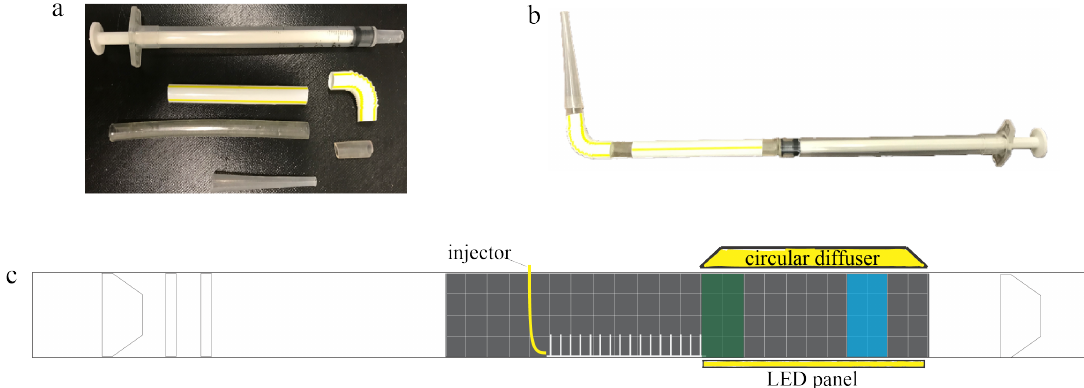
Figure 4. Larvae injector with a modified tip design: ( a ) the injector was constructed using a 1-mL insulin injector, 65-mm and 10-mm sections of aquarium tubing with 5 mm diameter, a straight 45-mm plastic straw piece, a 19-mm bendy section of the straw, and the tip of a 3-mL pipette that has an opening that is 2 mm in diameter and 35 mm in length; ( b ) the complete injector as assembled; and ( c ) flow tank setup for the dispersal experiments. The injector was positioned immediately upstream of the macrophyte model. Green and blue rectangles denote the green and blue zones, respectively, where the concentrations of brine shrimp were recorded. A circular diffuser and LED panel wrapped in plain paper to serve as a diffuser were placed above and below the tank immediately after the